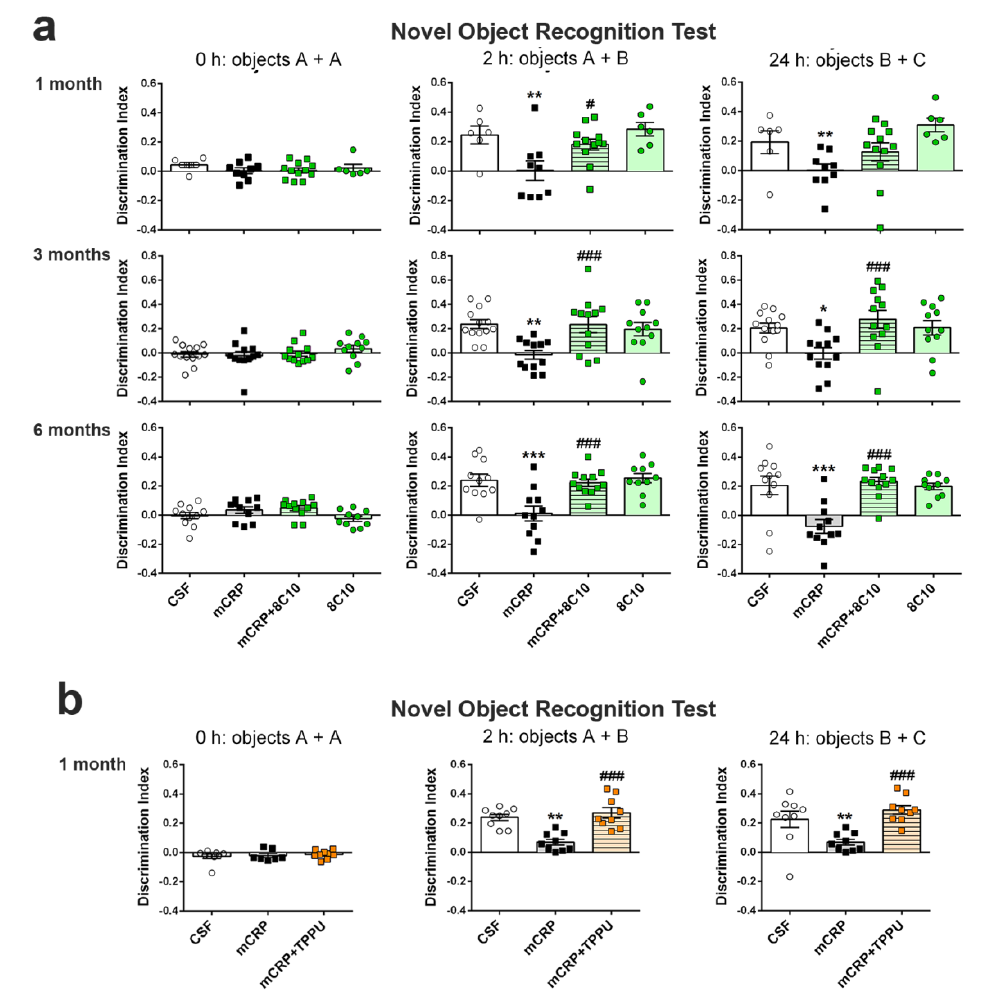
Figure 3. Long-term loss of recognition memory induced by mCRP was prevented by 8C10 antibody. ( a ) 1, 3 and 6 months of exposure to mCRP induced total memory loss shown at 2 and 24 h after an assay of recognition learning in the Novel object recognition test. 8C10 totally prevented memory loss for all the assayed periods. ( b ) TTPU similarly protected against loss of recognition memory after 1 month of exposure to mCRP. Values are mean ± SEM (( a ) 1 month: CSF N = 6, mCRP N = 9, mCRP + 8C10 N = 12 and 8C10 N = 6; 3 months: CSF N = 13, mCRP N = 12, mCRP + 8C10 N = 12 and 8C10 N = 11; 6 months: CSF N = 11, mCRP N = 11, mCRP + 8C10 N = 12, 8C10 N = 10. ( b ) CSF N = 9, mCRP N = 9 and mCRP + TPP N = 9). Statistics: * p < 0.05, ** p < 0.01, *** p < 0.001, compared to Control group; # p < 0.05, ### p < 0.001 compared to mCRP group.